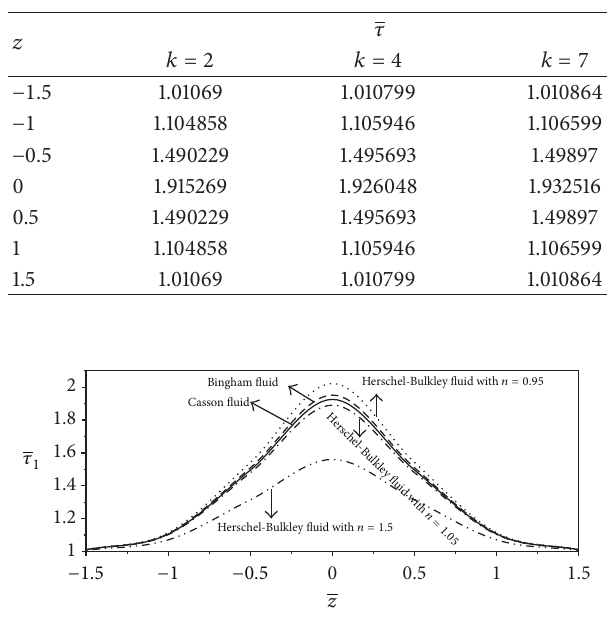
Figure 6: Variations of skin friction 𝜏 1 with axial distance for different fluids.